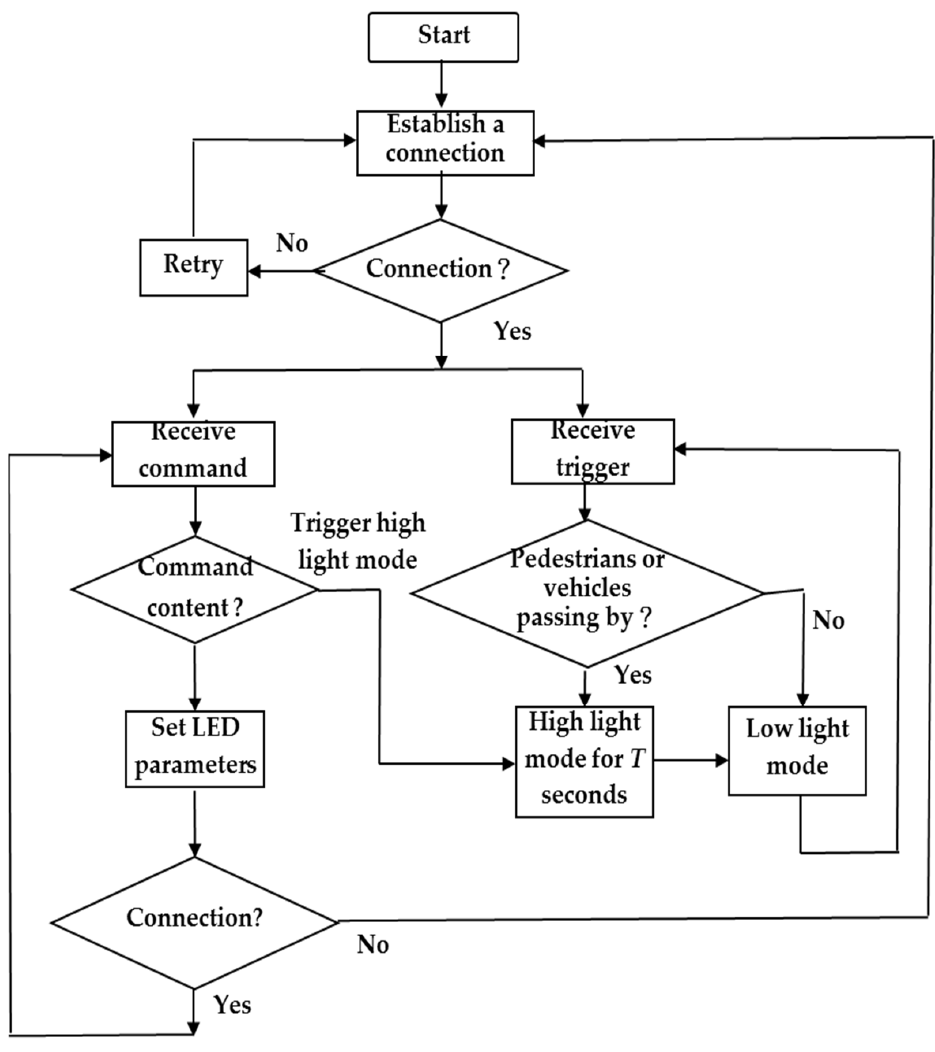
Figure 4. Flowchart of the system processes.